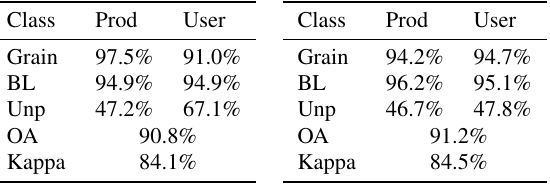
Table 10. Approach 4, June